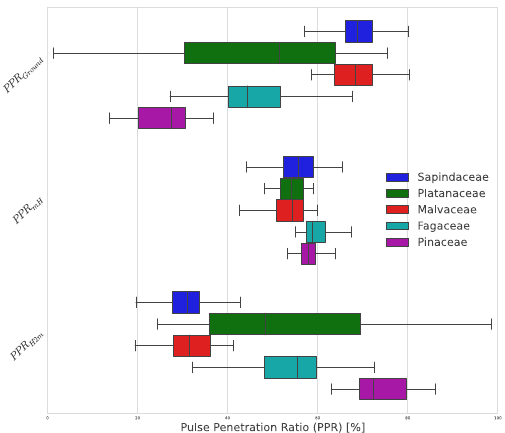
Figure 5. The pulse penetration ratio ( PPR ) differentiated by tree family and related to the three levels i) ground ( PPR Ground ), ii) mean tree height ( PPR mH ) and iii) H thresh of 2 m ( PPR Hthresh ).